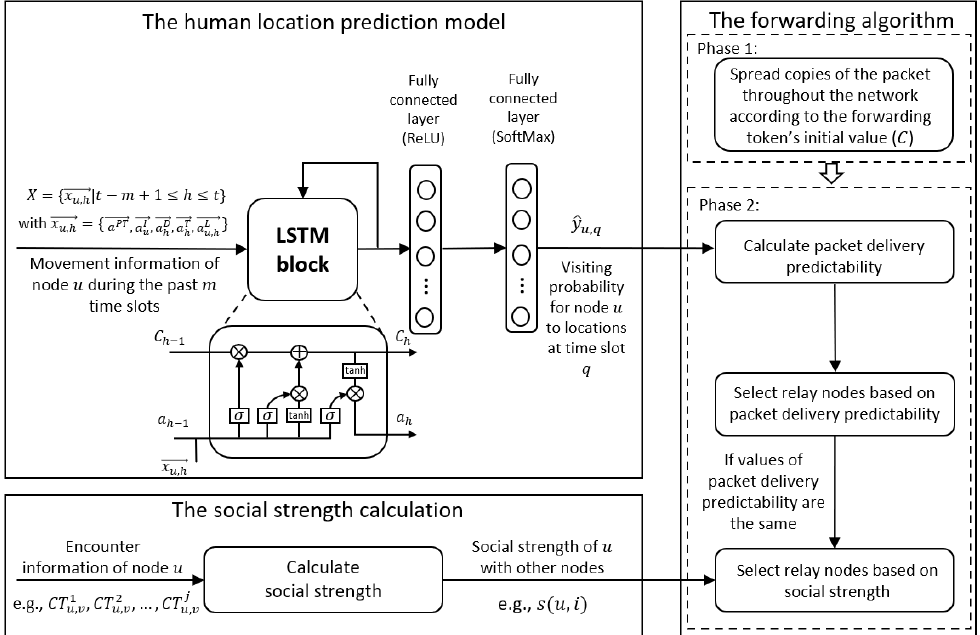
Figure 2. The HLPRP routing